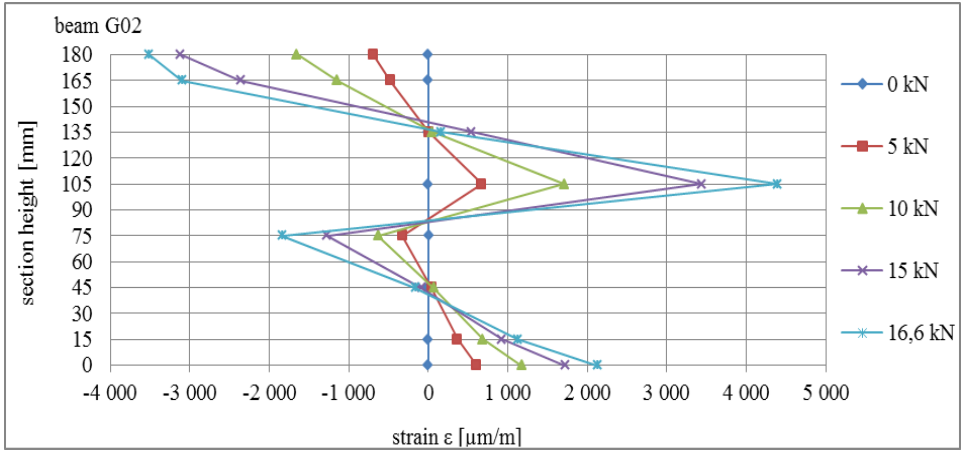
Figure 17. Strain profile in the cross-section for selected beams subjected to bending.